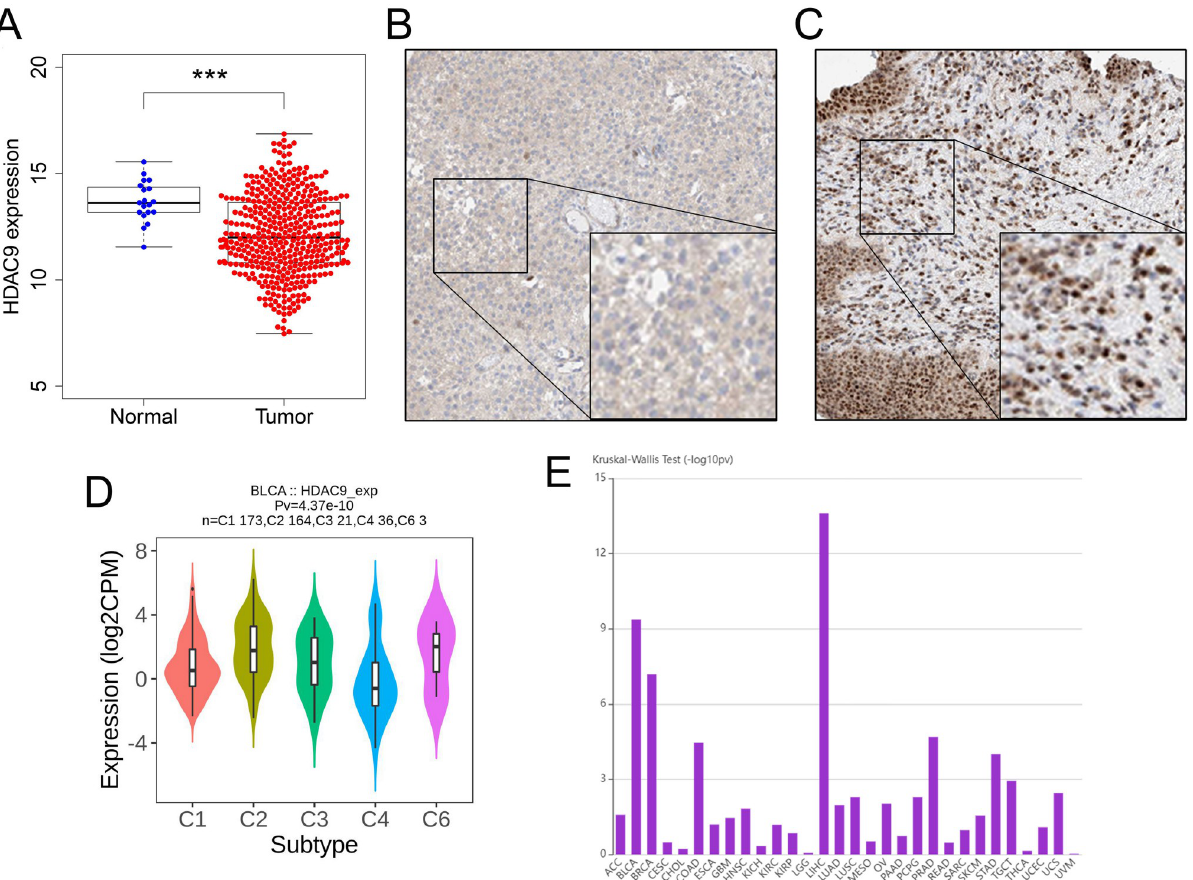
Fig 1. Preliminary exploration of HDAC9. According to TCGA data, low expression of HDAC9 was found in tumor samples (A). According to HPA data, lower expression of HDAC9 was found in tumor samples (B) than in normal samples (C). There was a significant difference between HDAC9 expression and immune subtype (D). It was worth noting that the significance level of the relationship between HDAC9 expression and immune subtypes in the BC ranked second among all tumors (E). HDAC9, histone deacetylase 9; TCGA, The Cancer Genome Atlas; HPA, Human Protein Atlas; BC, bladder cancer; C1, wound healing; C2, IFN-gamma dominant; C3, inflammatory; C4, lymphocyte depleted; C6, TGF-b dominant; ��� , P < 0.001.